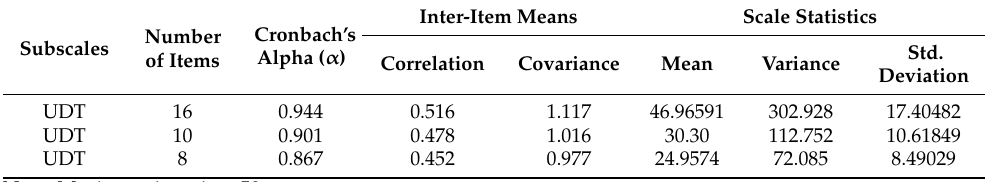
Table 1. Reliability analyses results of the pilot study. Number Subscales of Items